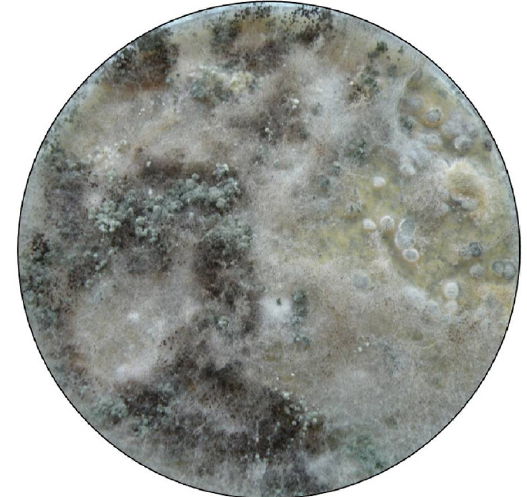
Figure 6. Photograph of the fungal colonies from the wash water of a sample after 90 days of exposure in the simulated